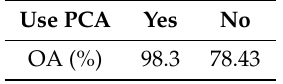
Table 5. The OA of Indian pines datasets in two different cases. PCA: principle component analysis.